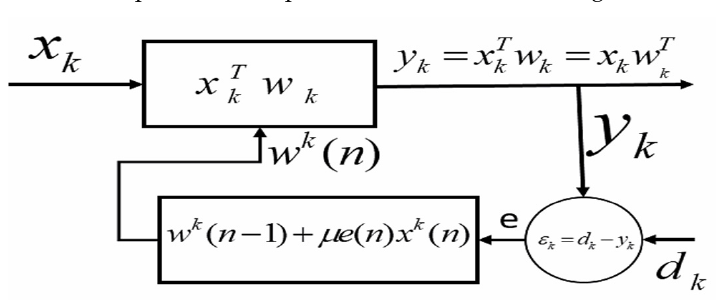
Figure 4. Adaptive LMS FIR structure.